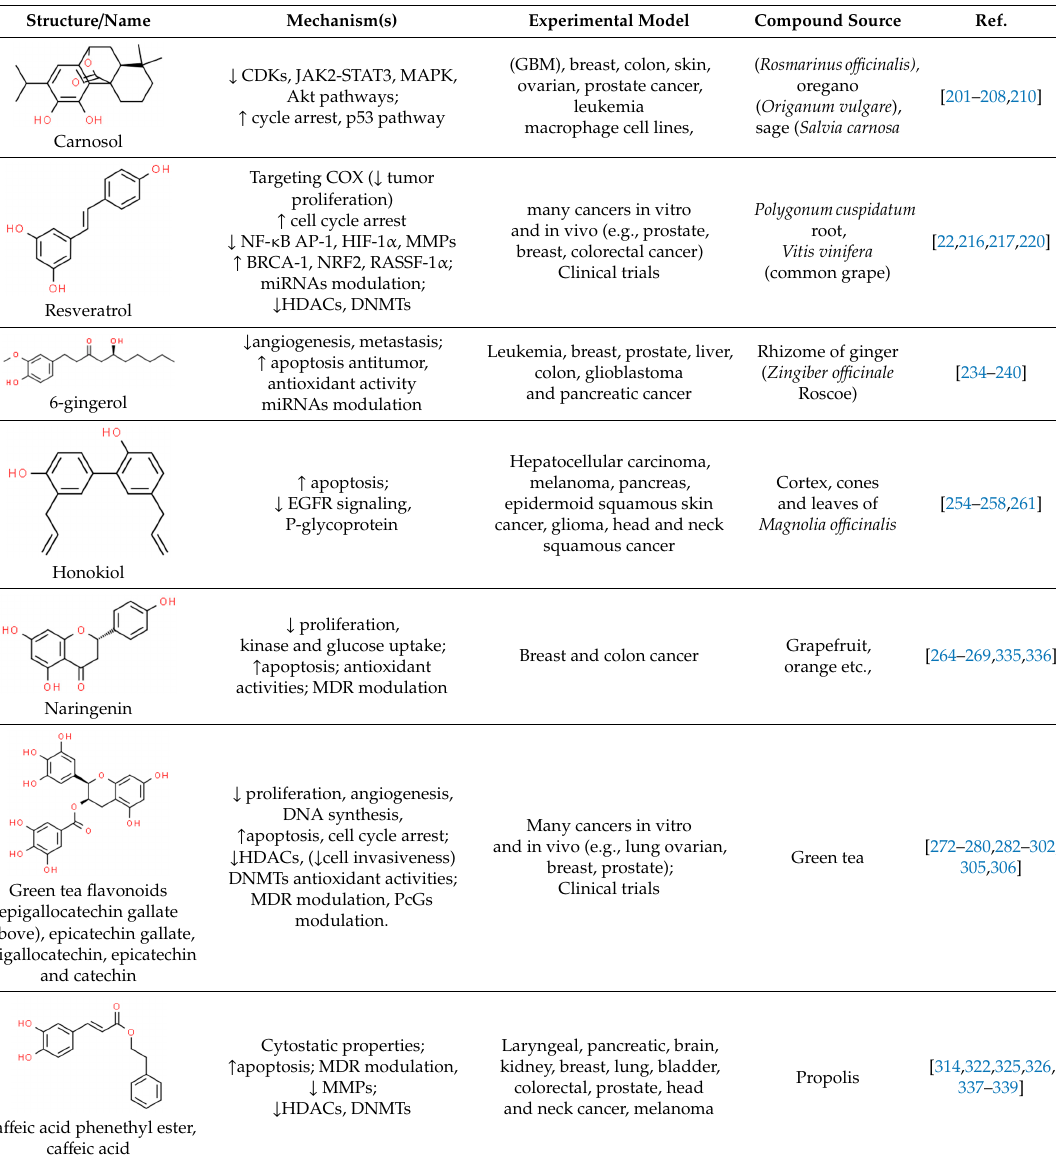
Table 4. Polyphenols—a brief summary. Images of the chemical structures obtained from ChemSpider database [52]. ↑ : upregulation / induction / stimulation. ↓ : downregulation / inhibition GBM—Glioblastoma multiforme, MDR—Multi-drug resistance, PcGs—Polycomb group proteins.